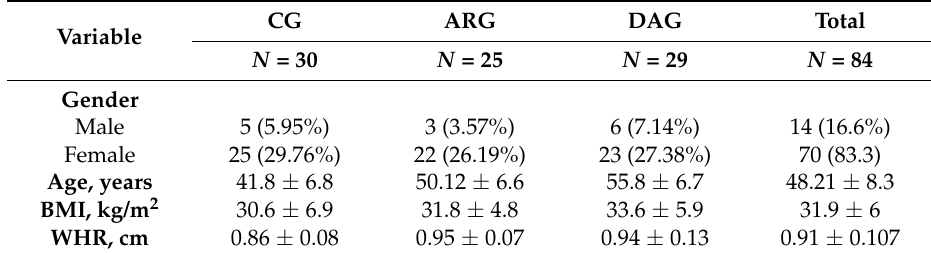
Table 1. General characteristics of the study participants across the clinical groups. CG—control group; ARG—at-risk of developing atherosclerosis group; DAG—diagnosed with atherosclerosis group; BMI—body mass index; WHR—waist to hip